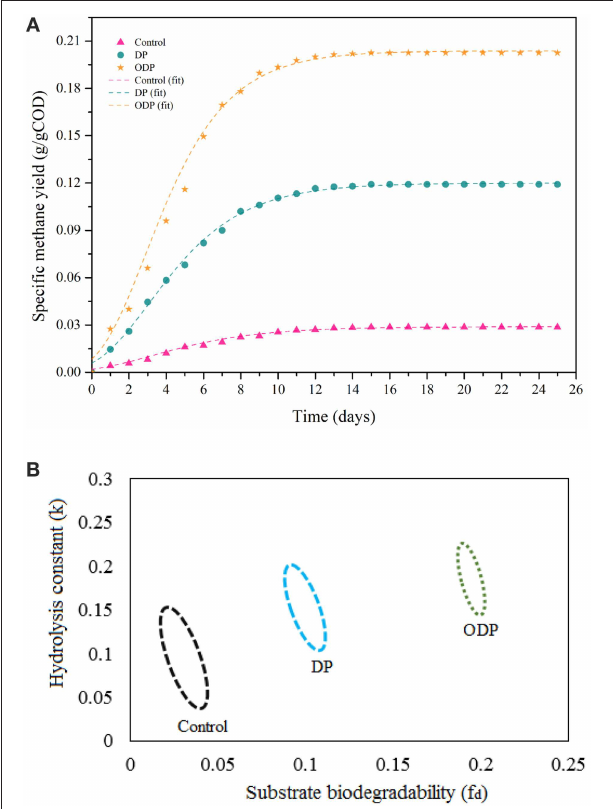
FIGURE 5 | (A) Plot showing methane production potential of different MAB samples. (B) Plot showing confidence regions of substrate biodegradability vs. hydrolysis constant for different MAB